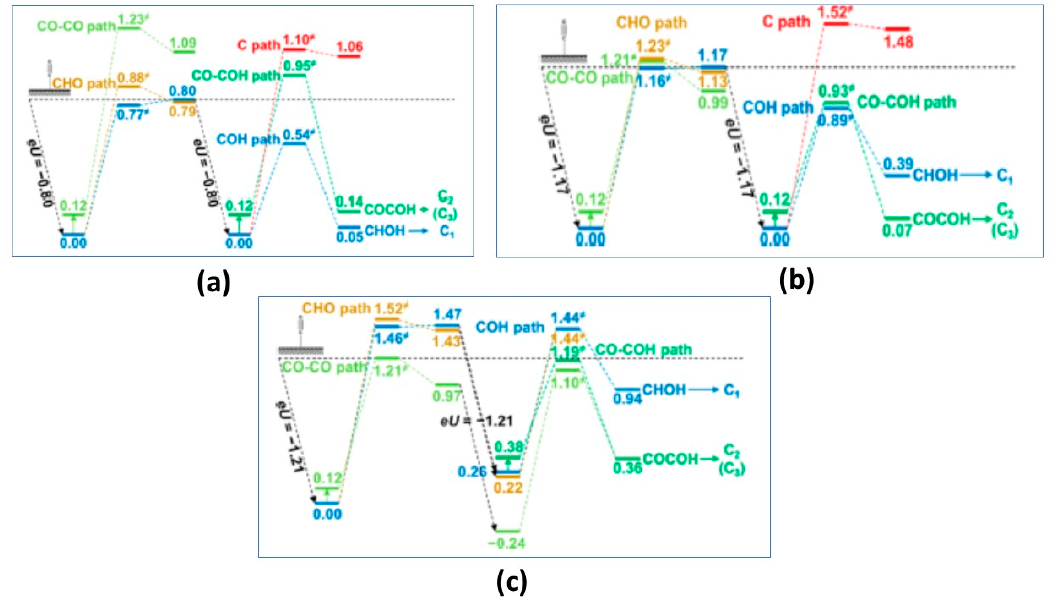
Figure 8. CO electro-reduction profiles as various pH. ( a ) pH = 1. The blue line is the kinetically dominant pathway. ( b ) pH = 7. Blue and green lines are the dominant pathway with the rate for the green line 20% of that of the blue line. ( c ) pH = 12. The light green line is the most dominant pathway. Adapted and reprinted with permission from Ref. [61]. https://pubs.acs.org/doi/abs/10.1021%2Fjacs. 5b11390. Further permissions related to the material excerpted should be directed to the